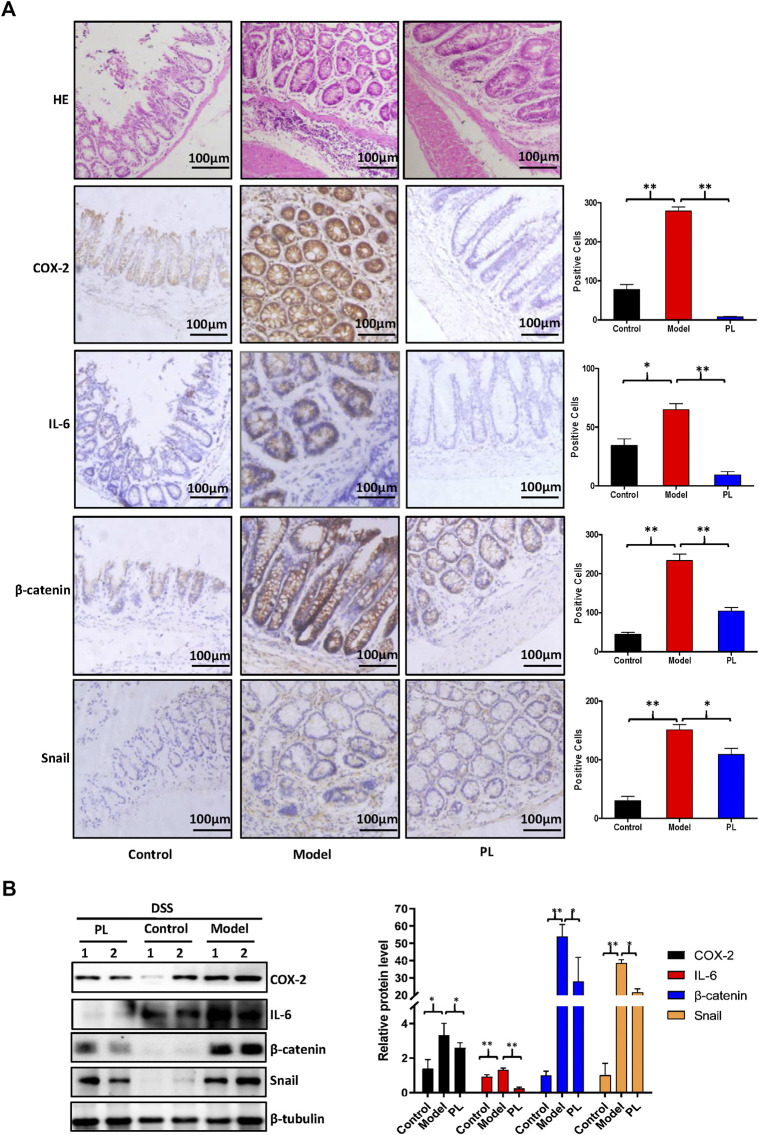
Piperlongumine (PL) inhibits the protein expressions of cyclooxygenase-2 (COX-2), interleukin-6 (IL-6), β-catenin, and snail in dextran sulfate sodium (DSS)-induced acute colitis mouse models. (A) Colon sections were stained with H&E and the indicated antibodies. (B) The protein expression was examined by Western blot with the indicated antibodies after lysing colon tissues from two mice of each group, and β-tubulin was used as loading control. The representative results and quantified data are shown. Note: Control, no treated group; model, DSS-treated group; PL, DSS in combination with PL-treated group. *p < 0.05, and **p < 0.01 vs. corresponding group.